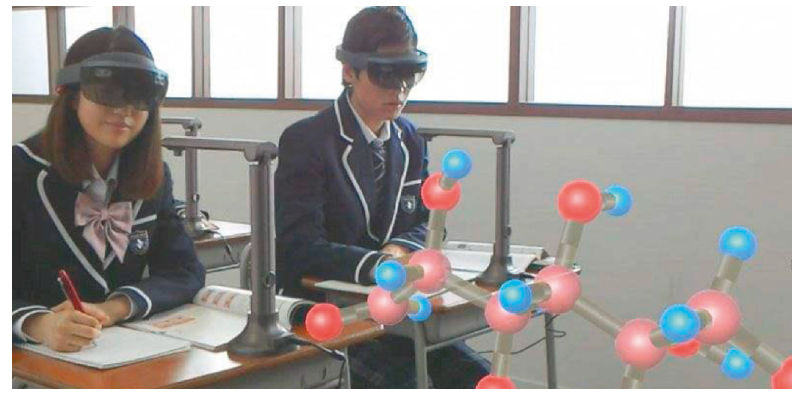
Figure 1: Classroom 3D video